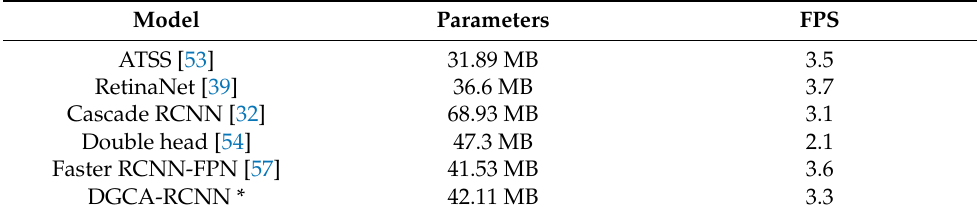
Table 3. The number of parameters and FPS for the different models.